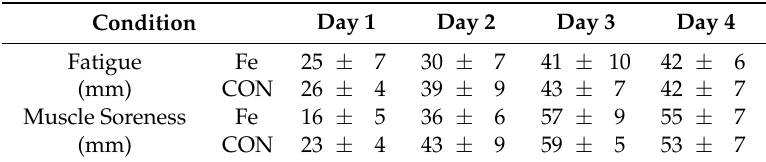
Table 3. Scores of fatigue and muscle soreness during training